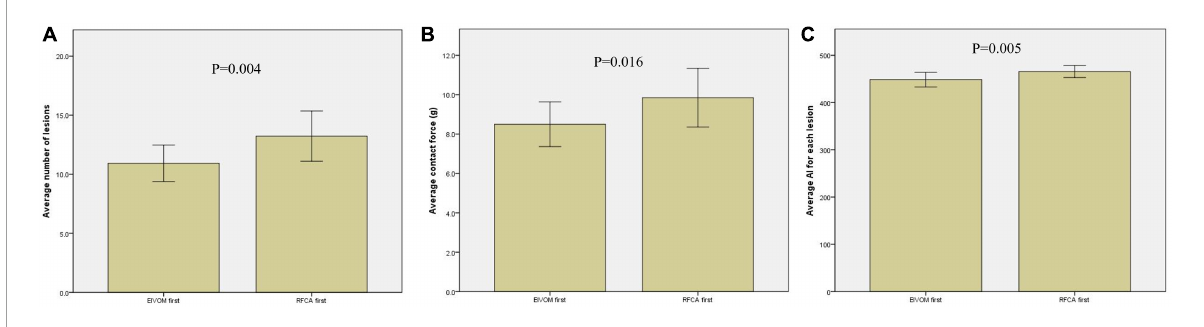
FIGURE3 Comparison of RF ablation parameters between the “EIVOM first” and “RFCA first” group. The average ablation index (AI) (A) , contact force (B) , and number of lesions (C) was significantly greater in “RFCA first” group than those in “EIVOM first” group.